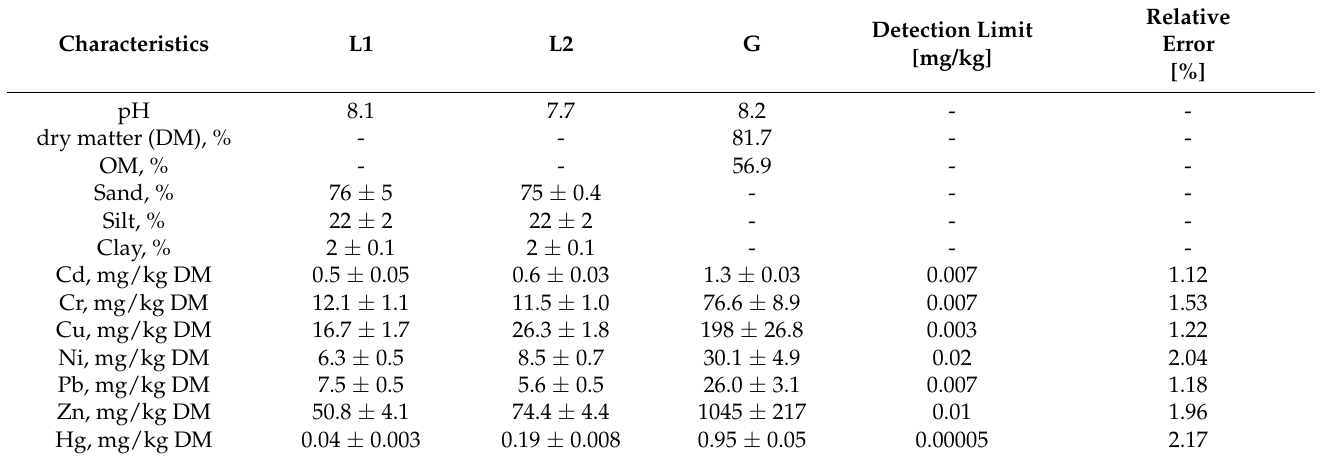
Table 1. Properties of soil on L1 and L2 and sewage sludge used in the